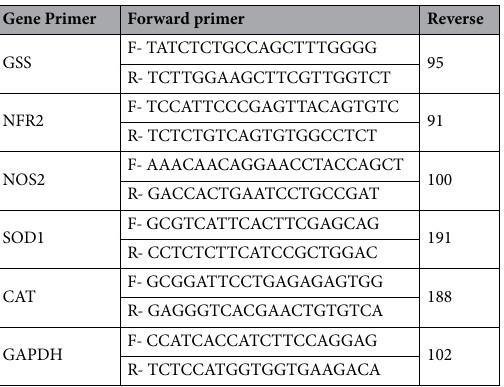
Table 4. Sequences of forward and reverse primers used for RT-PCR. Determined by the formula 2(-ΔCq) (Pfaffl, 2001). GSS Glutathione synthetase, NRF-2 Nuclear factor erythroid 2-related factor-2, NOS-2 Nitric Oxide Synthase-2, SOD-1 Superoxide Dismutase, CAT catalase, GAPDH Glyceraldehyde 3 ‐ phosphate dehydrogenase